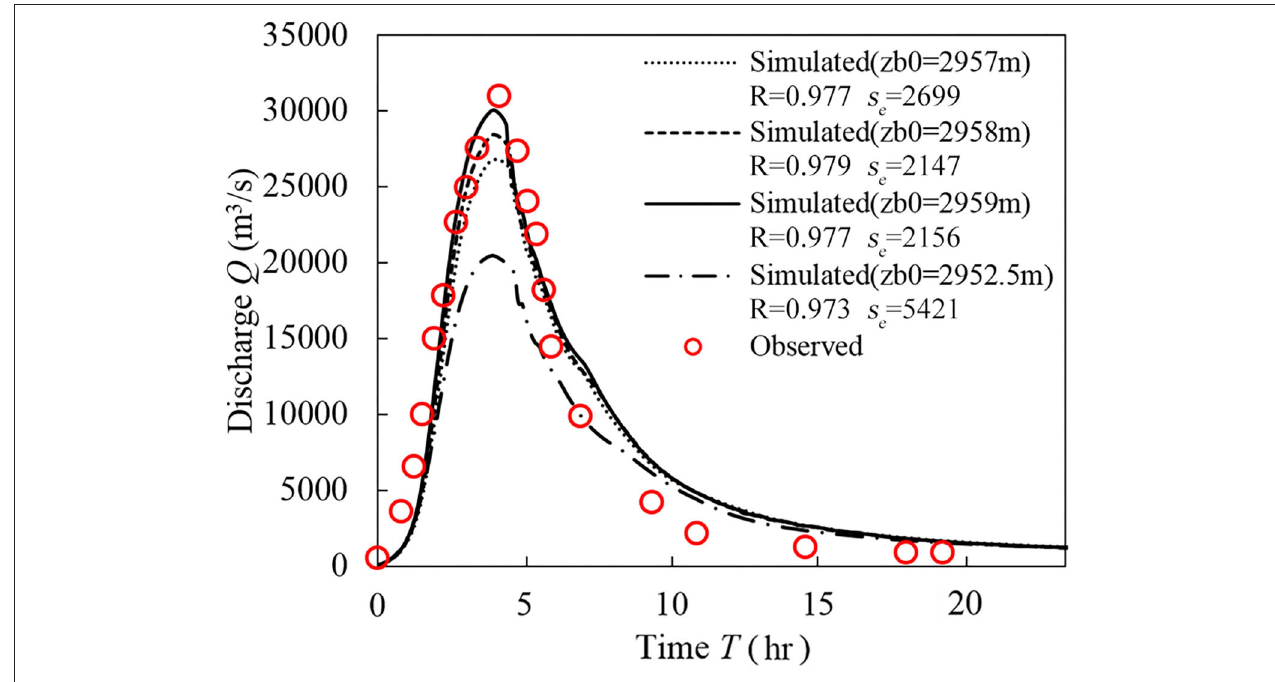
FIGURE 14 | The observed hydrograph of “November 3” Baige barrier lake and simulated results of different initial spillway bed elevations. The Pearson correlation coefficients R under different dam heights vary in the range of 0.973–0.979, and the values of root mean square error RMSE ( s e ) vary in the range of 2,147–5,421.